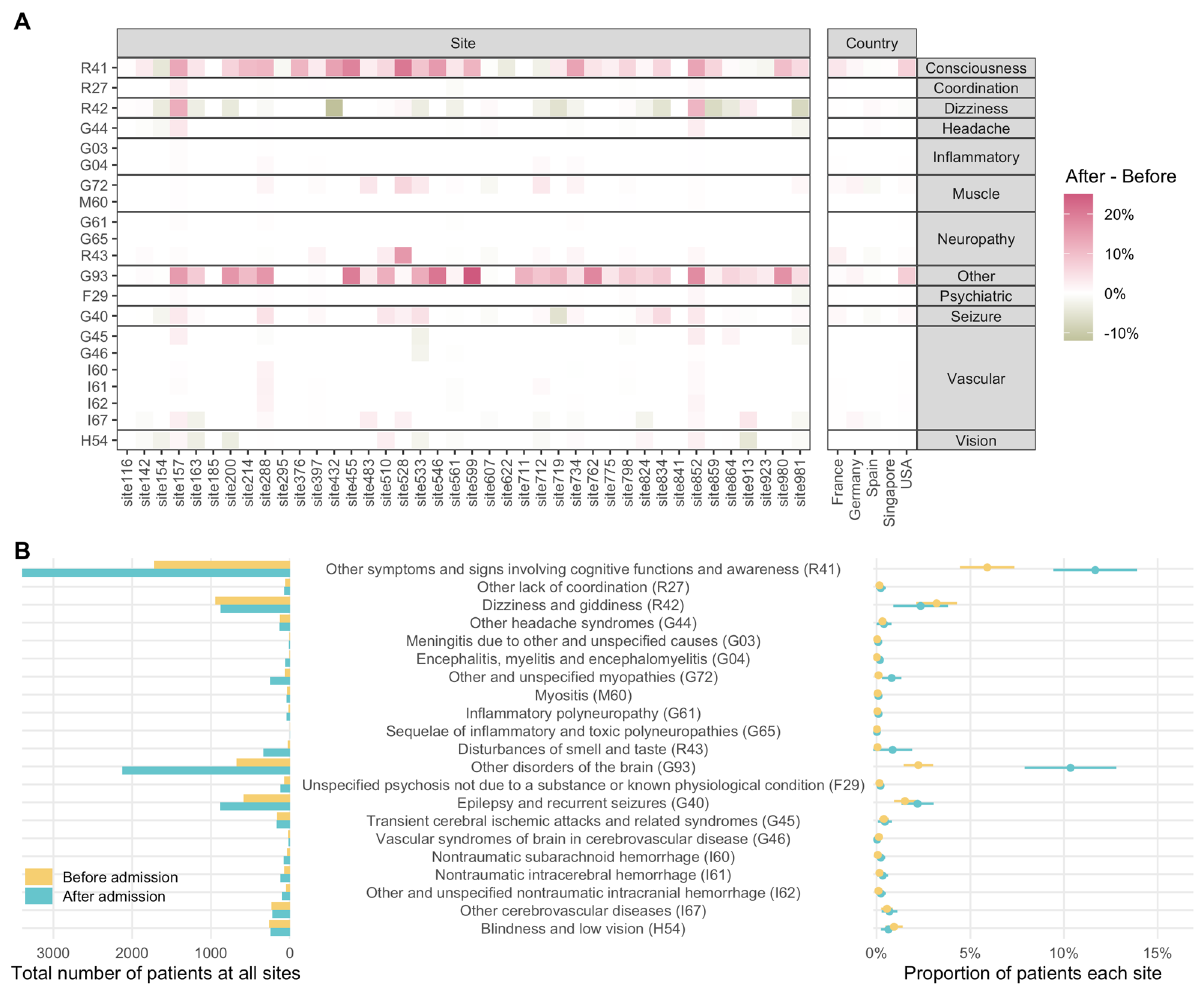
Figure 3. Prevalence of neurological phenotypes among all patients. ( A ) Difference in prevalence of each neurological ICD-10 code by healthcare system and country, calculated as after admission—before admission date (eEq. 2). Pink color on the heat map indicates increased prevalence, while green color indicates decreased prevalence. Please see eFig. 1 for the absolute values of prevalence. ( B ) Total counts of patients with a given neurological ICD-10 code (left) and the mean proportion of patients (right) before and after admission date across all healthcare systems. The mean proportion estimates are shown as circles and the 95% confidence intervals are shown as